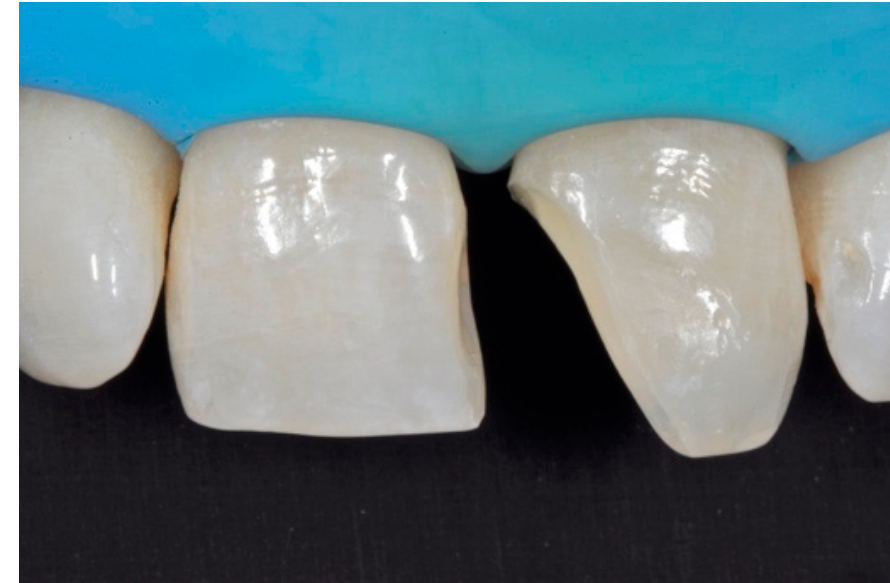
Figure 42. Preparation of Class III on #1.1 and Class IV on #2.1.